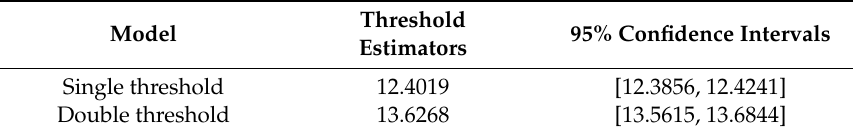
Table 3. Threshold values and confidence